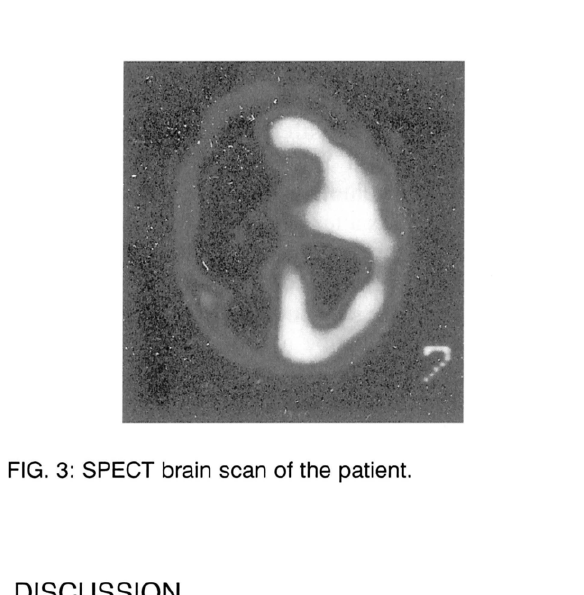
FIG. 3: SPECT brain scan of the